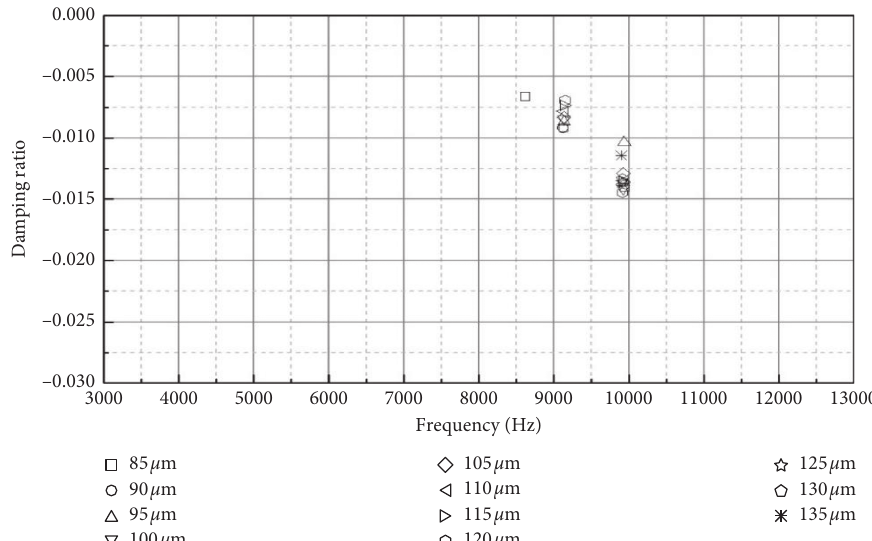
Figure 8: Noisy-mode distribution in Group B.